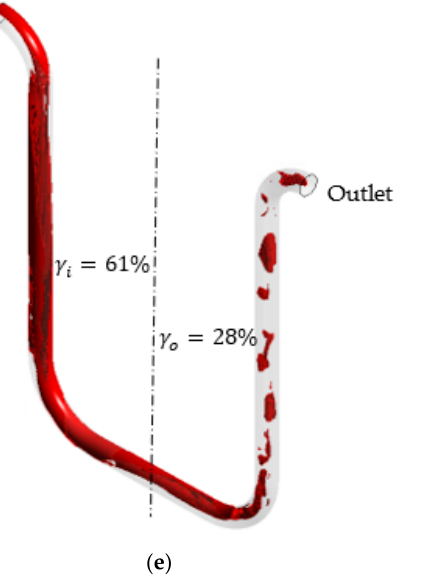
Figure 11. The gas distribution in flowmeter tube at different flow conditions obtained by numerical simulation at stratified and transitional flow regimes for CMF200. ( a ) 60.8 kg/min mixture flow rate, 9% GVF at the inlet, 13% gas asymmetry (𝛾 (cid:3031) ) , CMF200. ( b ) 149.0 kg/min mixture flow rate, 9% GVF at the inlet, 3% gas asymmetry (𝛾 (cid:3031) ) , CMF200. ( c ) 60.8 kg/min mixture flow rate, 16% GVF at the inlet, 38% gas asymmetry (𝛾 (cid:3031) ) , CMF200. ( d ) 100.0 kg/min mixture flow rate, 16% GVF at the inlet, 18% gas asymmetry (𝛾 (cid:3031) ) , CMF200. ( e ) 60.8 kg/min mixture flow rate, 13% GVF at the inlet, 33% gas asymmetry (𝛾 (cid:3031) ) , CMF200.